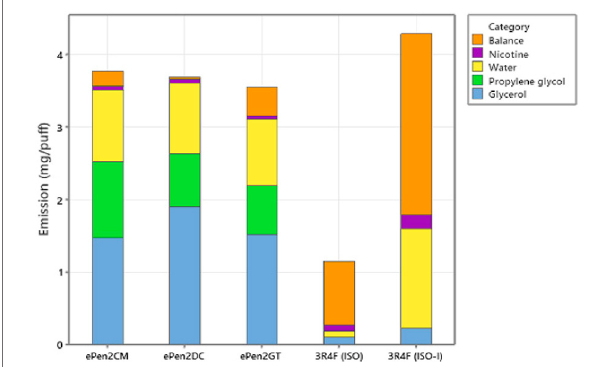
FIGURE3| Majorcomponentsoftheaerosolmassescollectedfromthe three e-cigarette variants and the mainstream smoke from the Ky3R4F reference cigarette smoked under ISO and ISO-Intense regimes. The balance is the difference between the total collected mass and yields of glycerol, propylene glycol, nicotine and water. Emissions are in mg/puff.